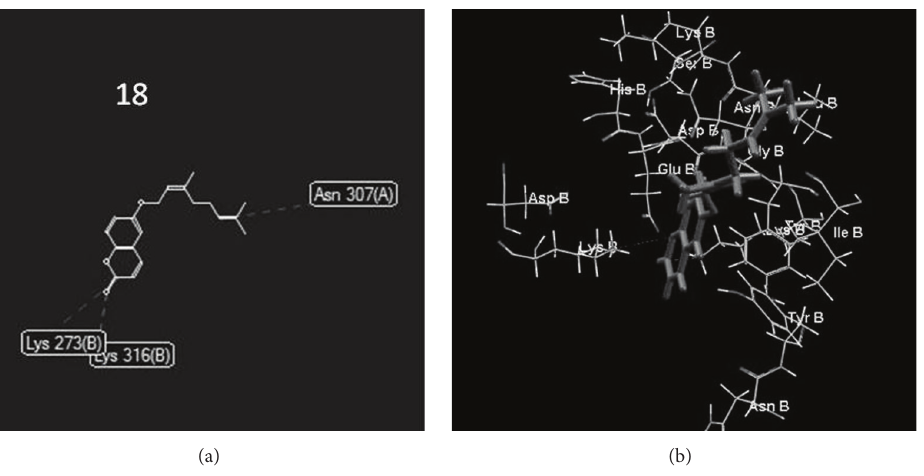
Figure 2: Interactions observed in the compound 18 -PBP